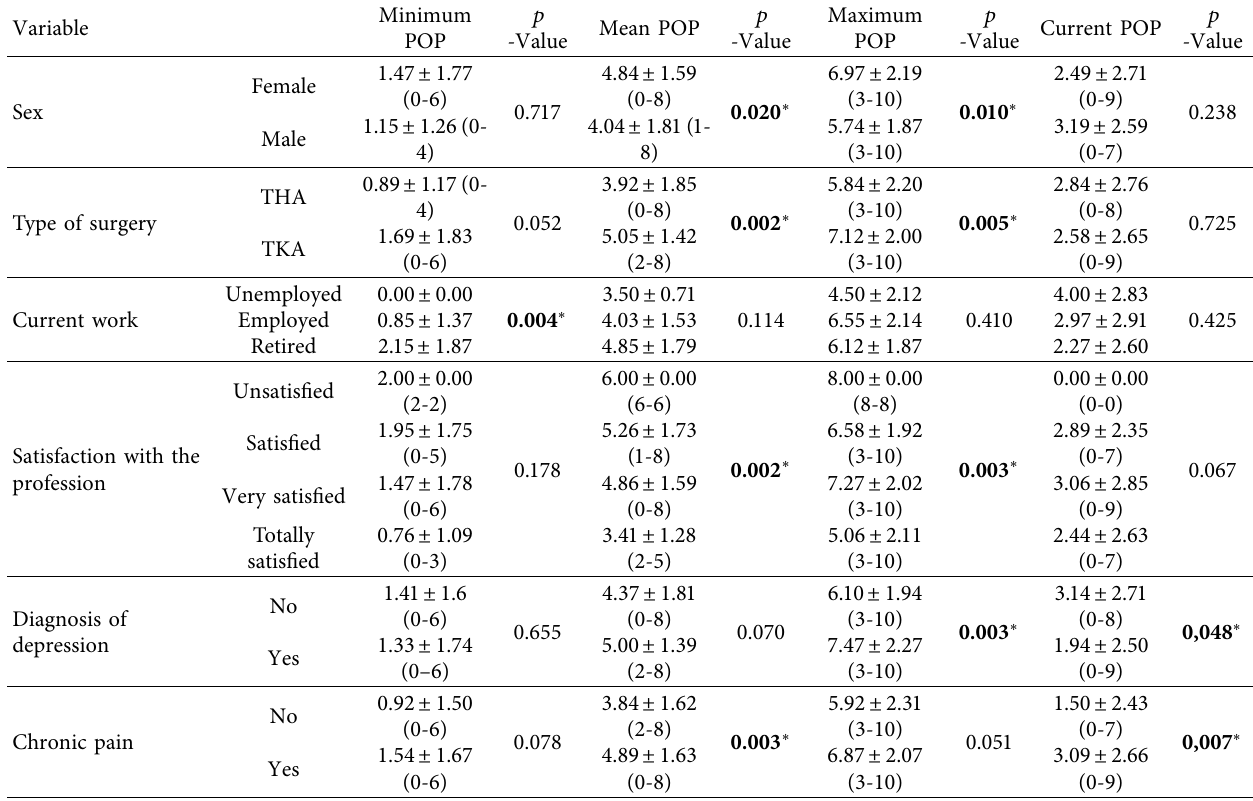
Table 2: Comparison of postoperative pain according to patient variables ( n � 95).